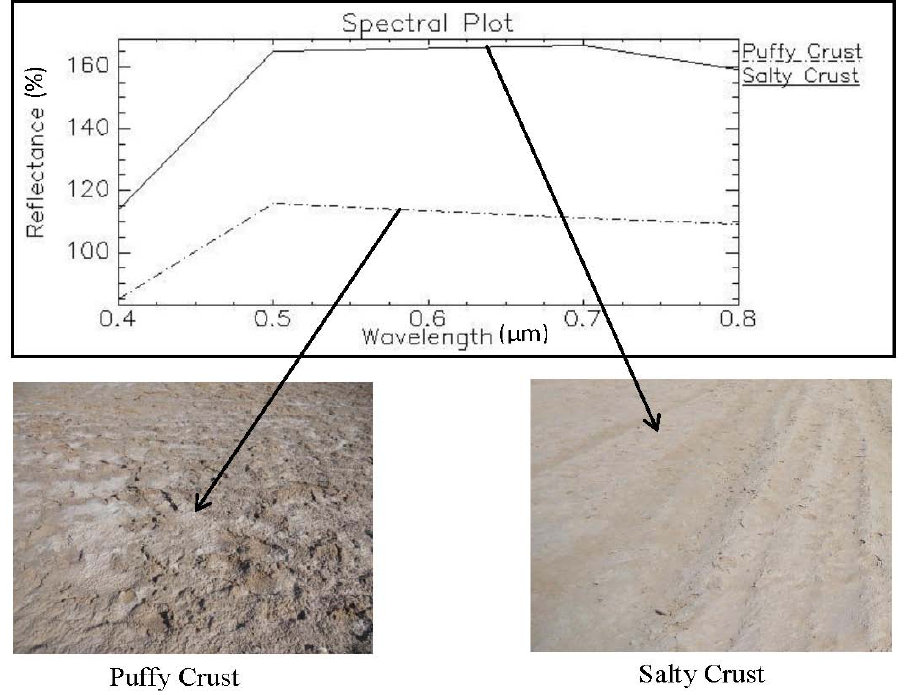
Figure 5. Spectral reflectance of saline soils differs due to surface roughness, crusting and